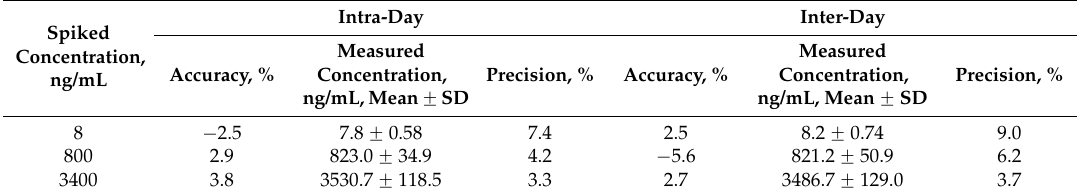
Table 2. Intra and inter-day accuracy and precision of taxifolin in rat plasma ( n = 6). Spiked Concentration, ng/mL